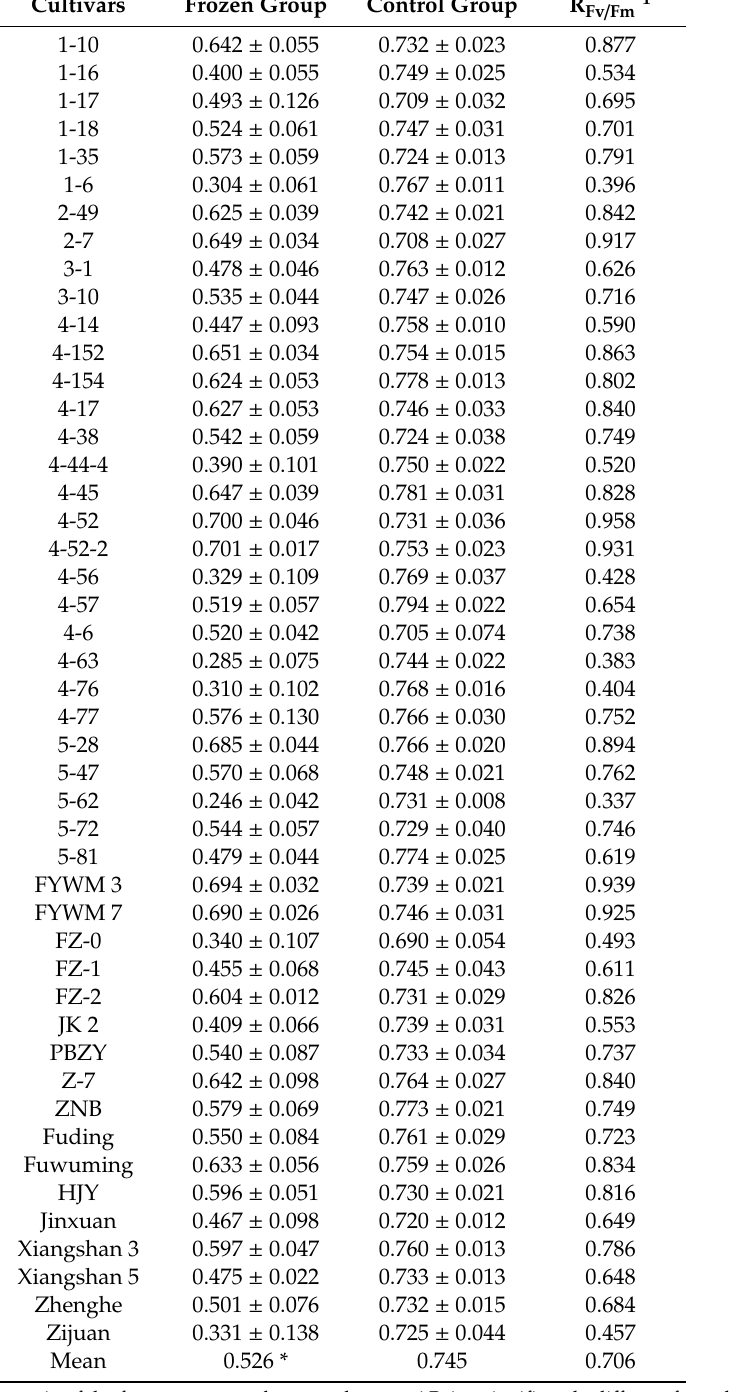
Table 2. E ff ects of freezing on Fv / Fm in leaves of various tea cultivars. Cultivars Frozen